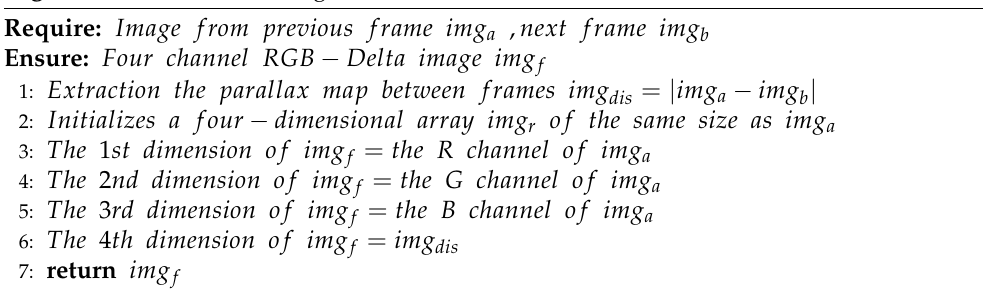
Figure 4. Original image and parallax chart of the indoor scene: ( a ) Original image ( b ) parallax map. The pseudo-code of the algorithm is shown in Algorithm 1. The grayscale map of parallax information is used as the fourth channel Delta data, fusing with the original RGB three-channel image of the scene to generate RGB-Delta data. These data are then fed into the neural network instead of the original RGB image, as Laina et al. [33] did. The processing flow is shown in Figure 5. Algorithm 1 RGB-Delta image data